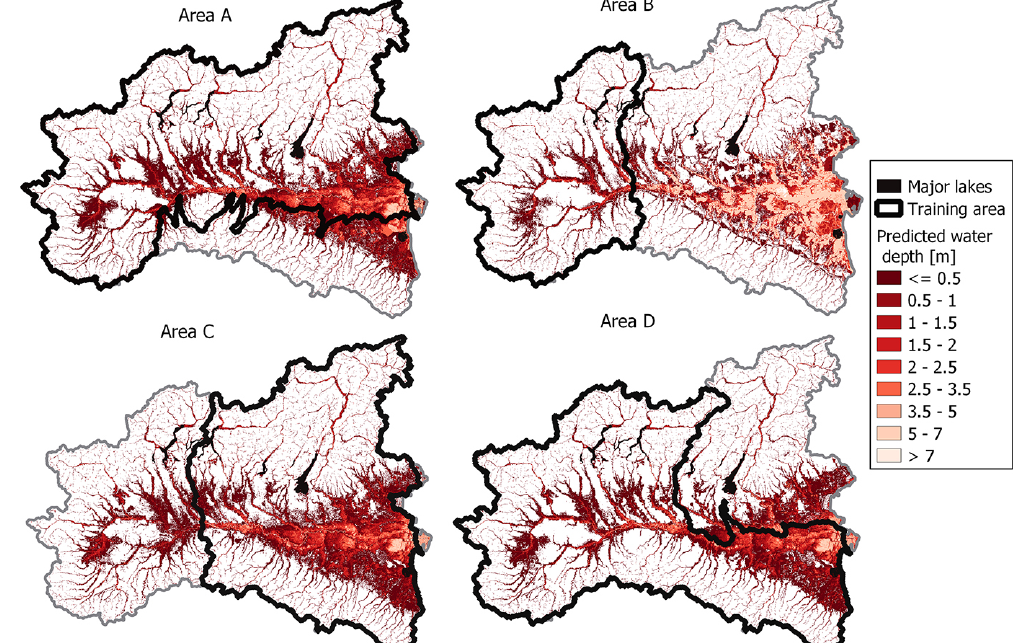
Figure 12. Geographical extrapolation for the regression problem: multivariate flood susceptibility maps obtained from regressor DTs (see also Fig. 4; target flood hazard map: JRC